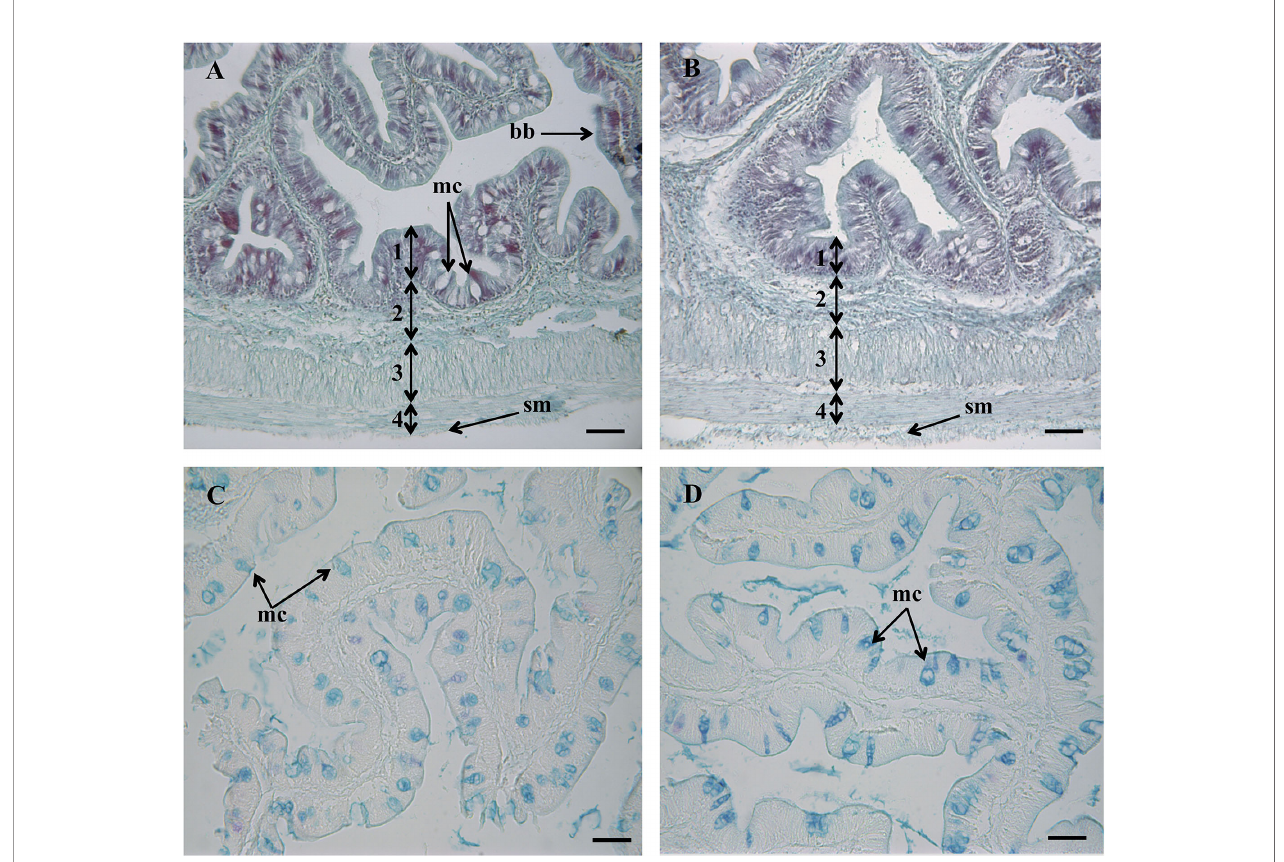
FIGURE 1 | Histological organization in the intestine of gilthead seabream ( Sparus aurata ) fed a control diet (A) , and medicinal plant leaf extract (MPLE)- supplemented diet (B) . Numbers indicate the different intestinal layers: (1) mucosa; (2) lamina propria-submucosa; (3) circular muscle layer; (4) longitudinal muscle layer. bb: brush border; mc: mucous cells; sm: serous membrane. Histochemical properties of mucins secreted by intestinal goblet cells with regard to their content on carboxylated and/or sulphated acidic groups (Alcian Blue pH = 2.5) from fi sh the control diet (C) and the MPLE-supplemented diet (D) . mc, mucous cells. The MPLE included in the basal diet was obtained from sage ( Salvia of fi cinalis ) and lemon verbena ( Lippia citriodora ). Staining: hematoxylin-VOF (A, B) , Alcian Blue pH = 2.5/PAS (C, D) . Scale bar = 50